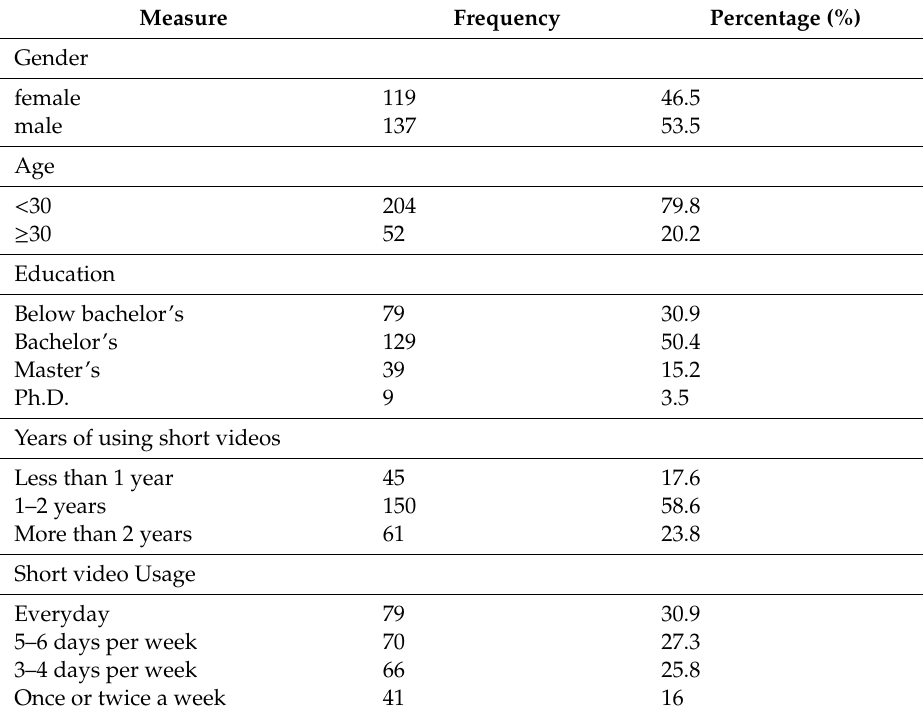
Table 2. Statistics of the surveyed